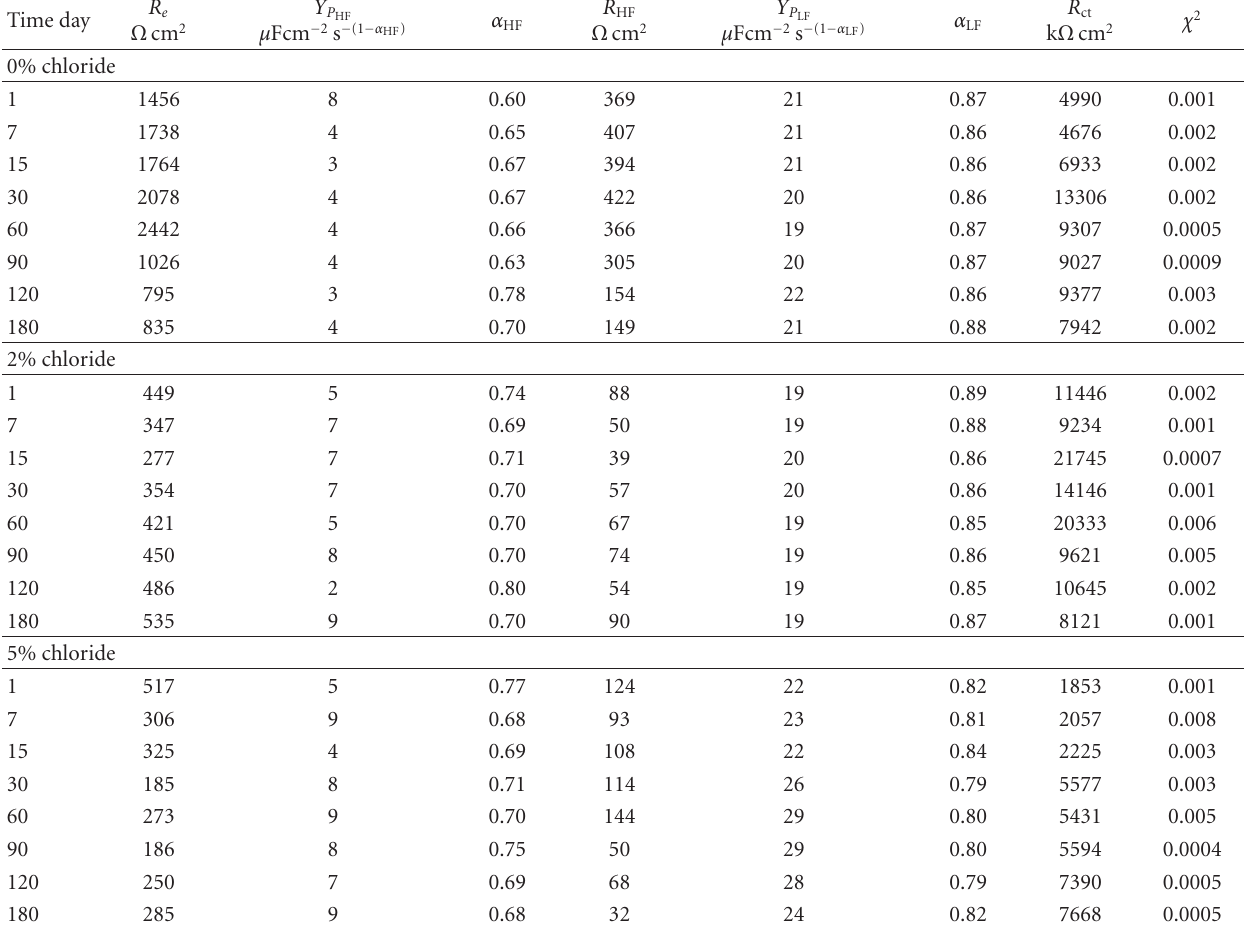
Table 4: Parameters used in the fitting of impedance data for low-nickel SS rebar embedded in A